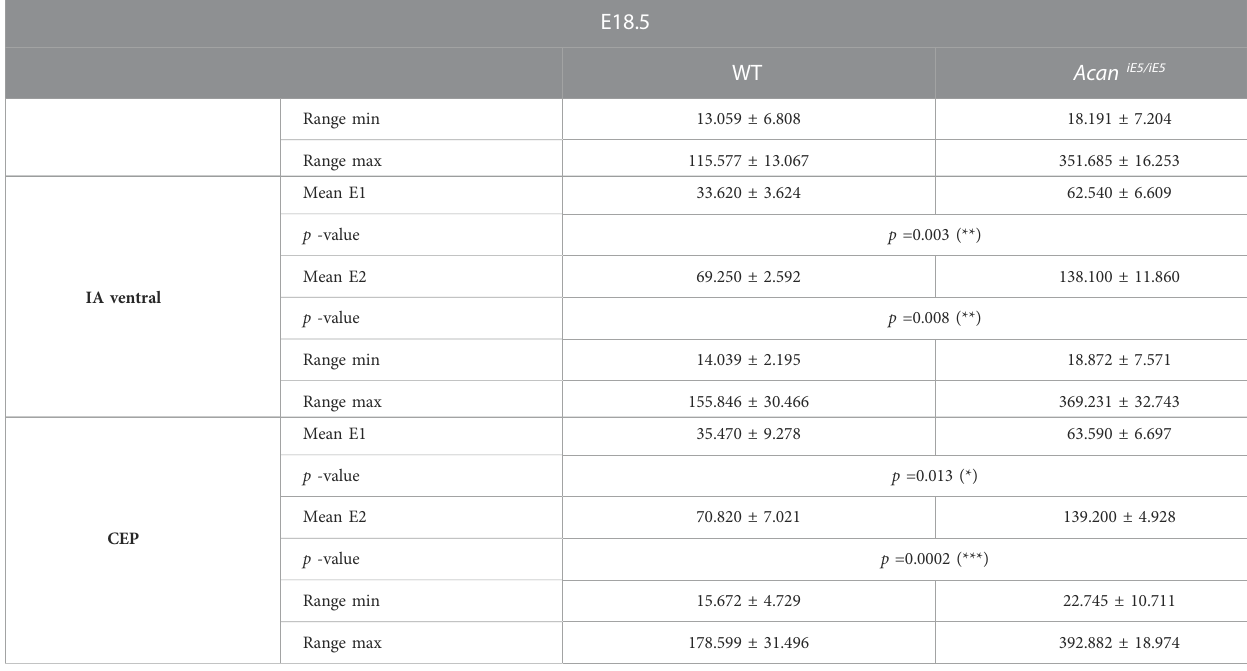
TABLE 1 ( Continued ) Summary of the calculated mean elastic moduli at the E12.5, E14.5 and E18.5 in the developing IVD